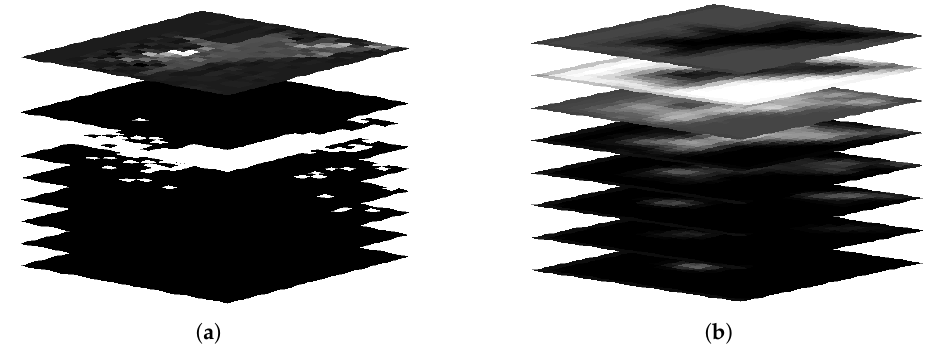
Figure 2. Aircraft distribution. ( a ) number of layers quantized to 8, and original image is superimposed at the top; ( b ) feature maps after